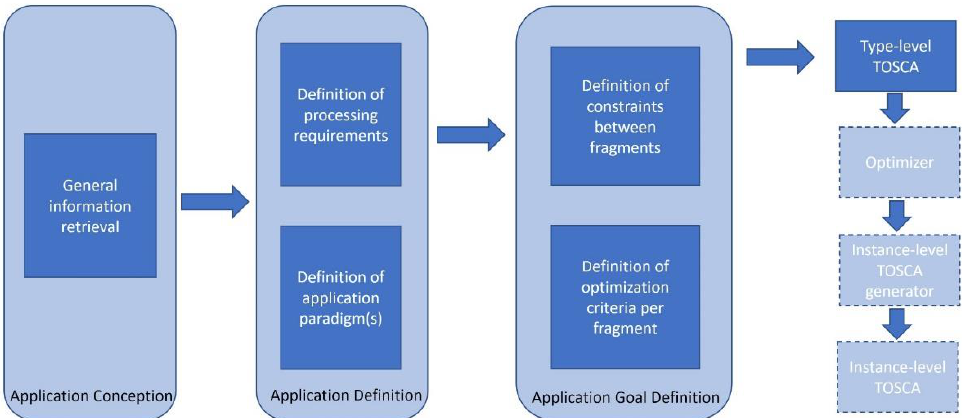
Figure 2. Overview of our approach. Although the optimization of the type-level TOSCA template and the generation of the instance-level TOSCA are essential constituents of our approach, we do not provide an implementation approach for an optimizer or an instance-level TOSCA.